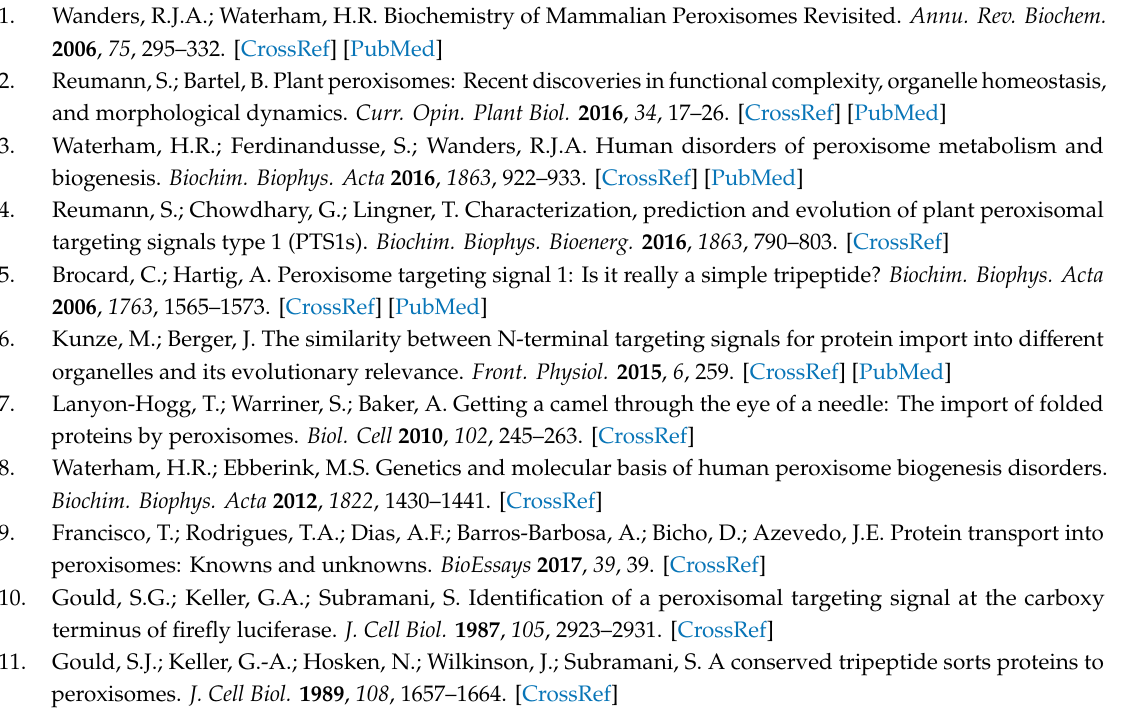
Figure S7: Systematic comparison of results from the investigation of the interaction between PEX5 and diverse PTS1, Figure S8: Competition experiments using either Cerulean-PTS1 (weak, Hs57) or Cerulean alone, Figure S9: Primary data for the experiments described in Figure 5, Figure S10: Primary data for the competition experiments described in Figure 5, Figure S11: Benchmarking, Table S12: Table of oligonucleotides used in this study, Table S13: Table of plasmids used in this study, Text S14: Extended Materials and